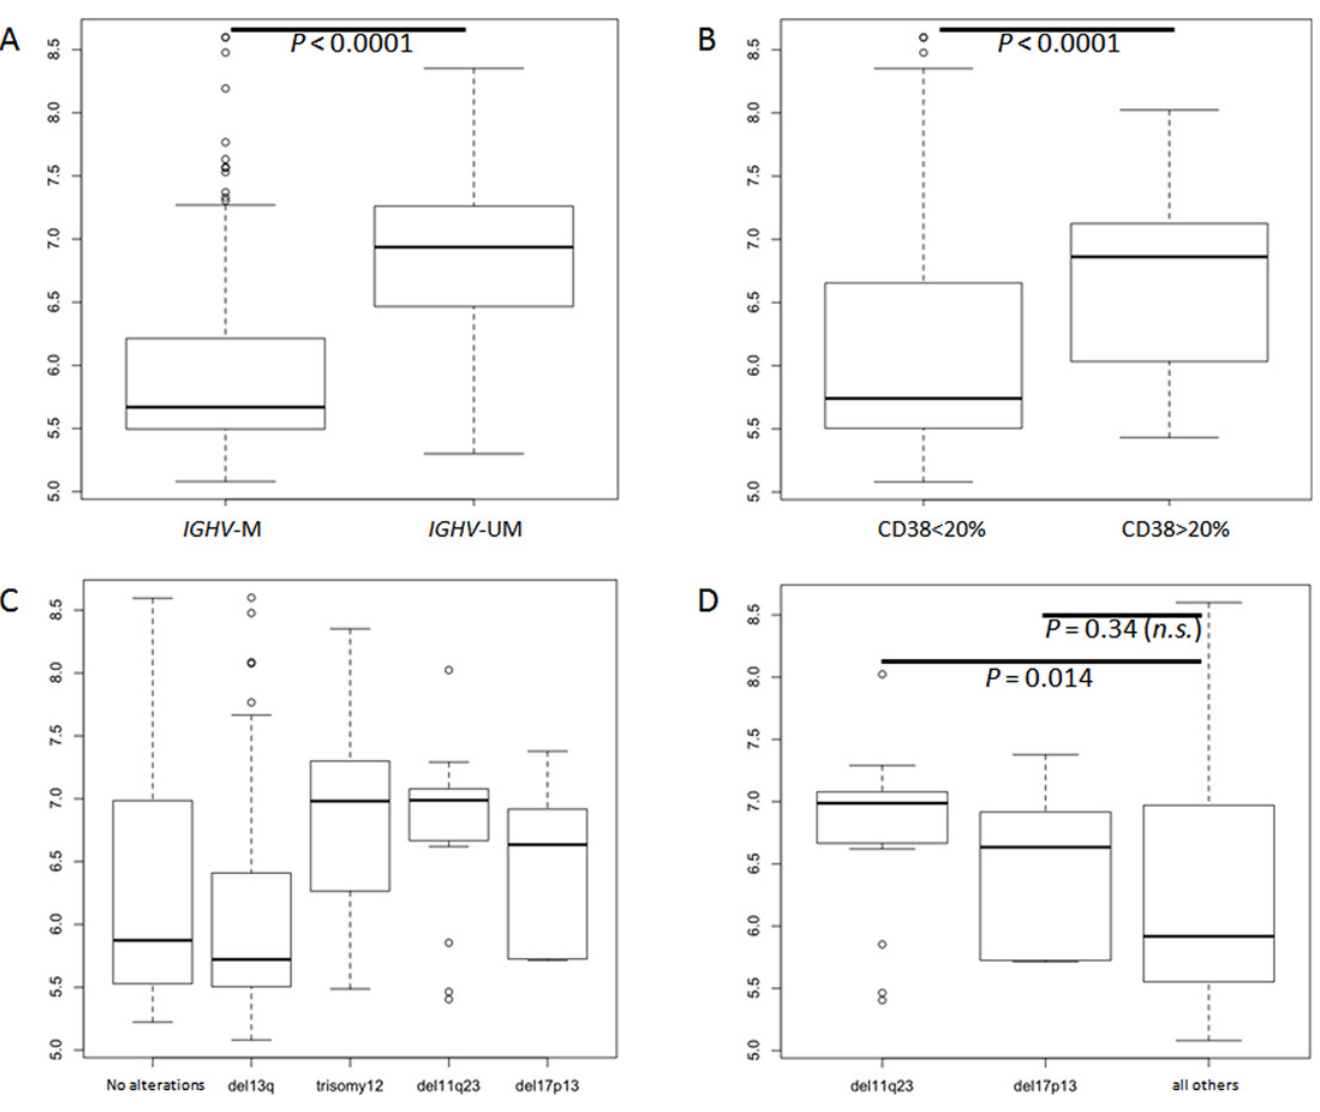
Fig 1. Boxplot of IGF1R expression (217 pts) in: A) IGHV -M vs IGHV -UM; B) CD38 < 20% vs CD38 > 20%; C) Most common cytogenetic aberrations evaluated by FISH; D) unfavorable cytogenetic deletions (del11q23 and del17p13) vs other patients (favorable/intermediate